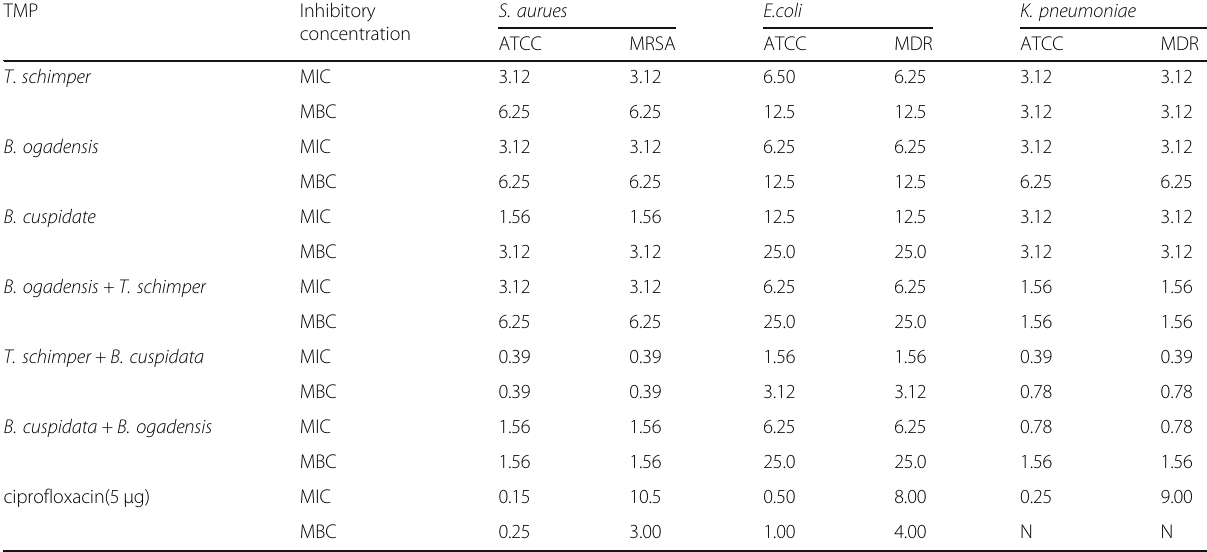
Table 4 Inhibitory concentrations of essential oils ( μ l/ml) against MDR bacteria in MHB at AAU, 2018 TMP Inhibitory S. concentration